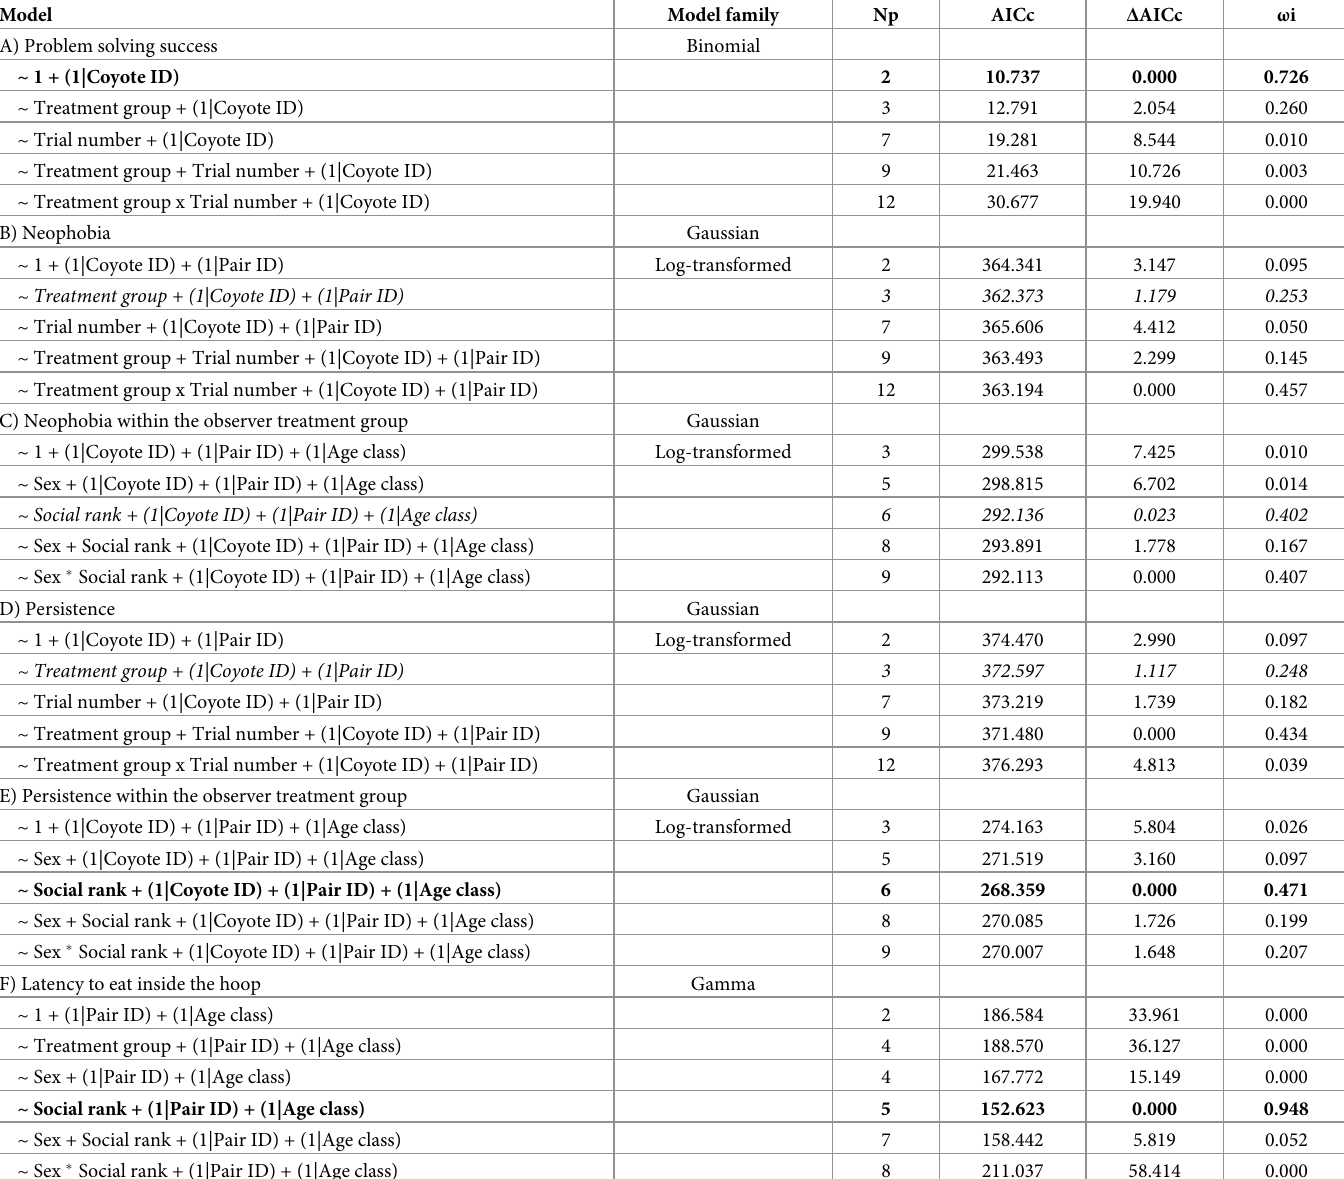
Table 5. Set of models fitted to assess the relationship between (A) problem solving success, (B) neophobia and (D) persistence and treatment group and trial num- ber, (C) neophobia, and (E) persistence within the observer treatment group and individual characteristics (sex and social rank), and (F) time to eat inside the hoop for unsuccessful coyotes in the post-trial tests and treatment group, sex, and social rank. The error distributions used in the models are specified by model family. Model comparison was based on AICc. Np is the number of parameters, Δ AICc is the difference between the candidate model and the model having the lowest AICc, and ω i is the AICc weight of each model. Models retained based on the lowest AICc value appears in bold, and models retained based on parsimony rules in italic